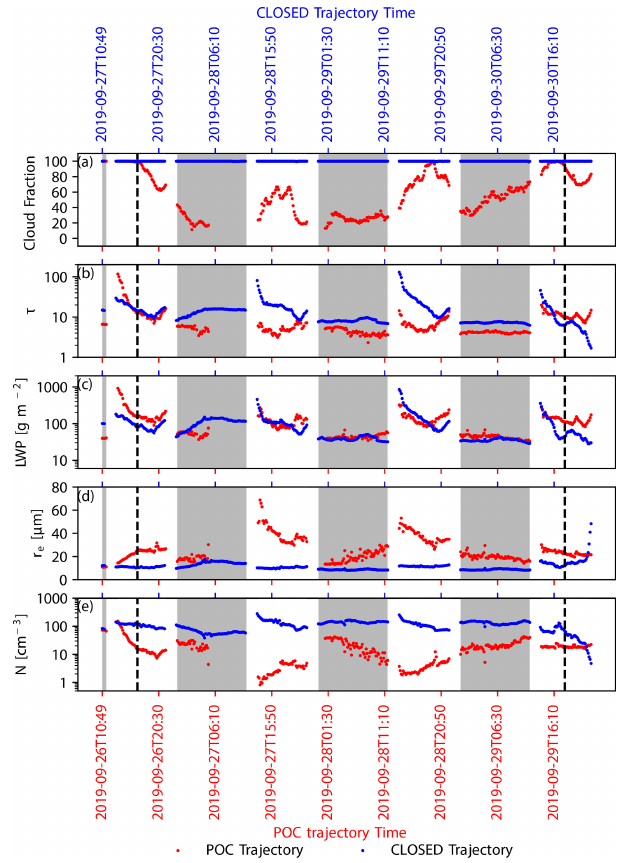
Figure 12. Changes in cloud fraction (a) , cloud optical depth (b) , liquid water path (c) , effective radius (d) , and cloud drop number concentration (e) are shown along the trajectory for one pocket of open-cell stratocumulus (POC) that occurred between 26 and 29 September 2019. The red dots correspond to a sample POC trajectory, while the blue dots correspond to the corresponding CLOSED trajectory. Gray shading indicates nighttime